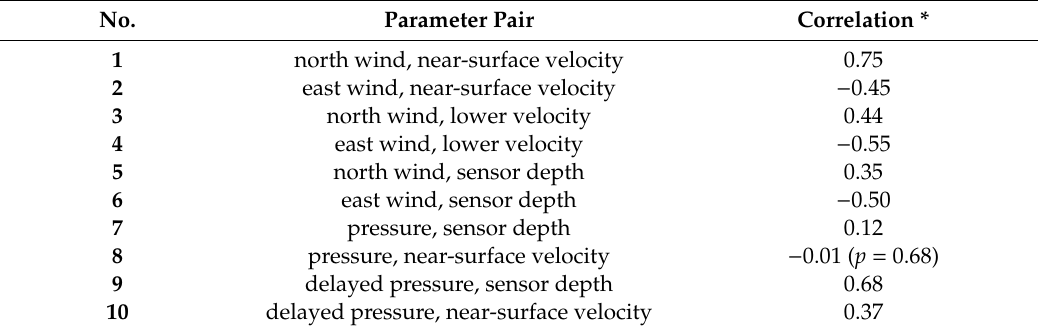
Table 3. Correlation coe ffi